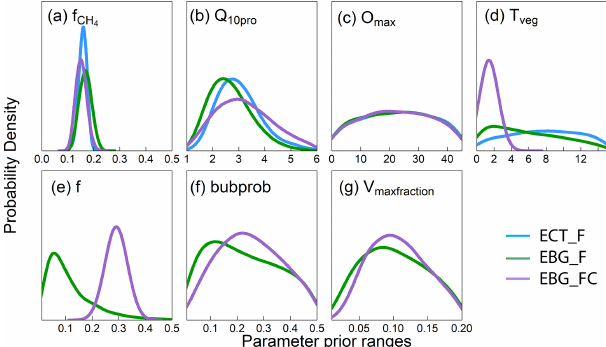
Figure 2. Posterior distribution of parameters that govern methane emission processes from data–model fusion. Parameters are defined in Table 2. Panels (a) and (b) are parameters related to methane pro- duction, (c) is a parameter related to methane oxidation, (d) is a pa- rameter related to plant transport, and (e–g) are parameters related to ebullition. X axes indicate the prior ranges of parameters used for data–model fusion. The blue lines are the parameter posterior dis- tributions (PPDs) from the ECT model structure trained with CH 4 emission data (ECT_F). The green lines are the PPDs from the EBG model structure trained with CH 4 emission data (EBG_F). The pur- ple lines are the PPDs from EBG trained with both CH 4 emission and CH 4 concentration data (EBG_FC). Well-constrained parame- ters have a unimodal distribution, whereas poorly constrained pa- rameter distributions tend to be